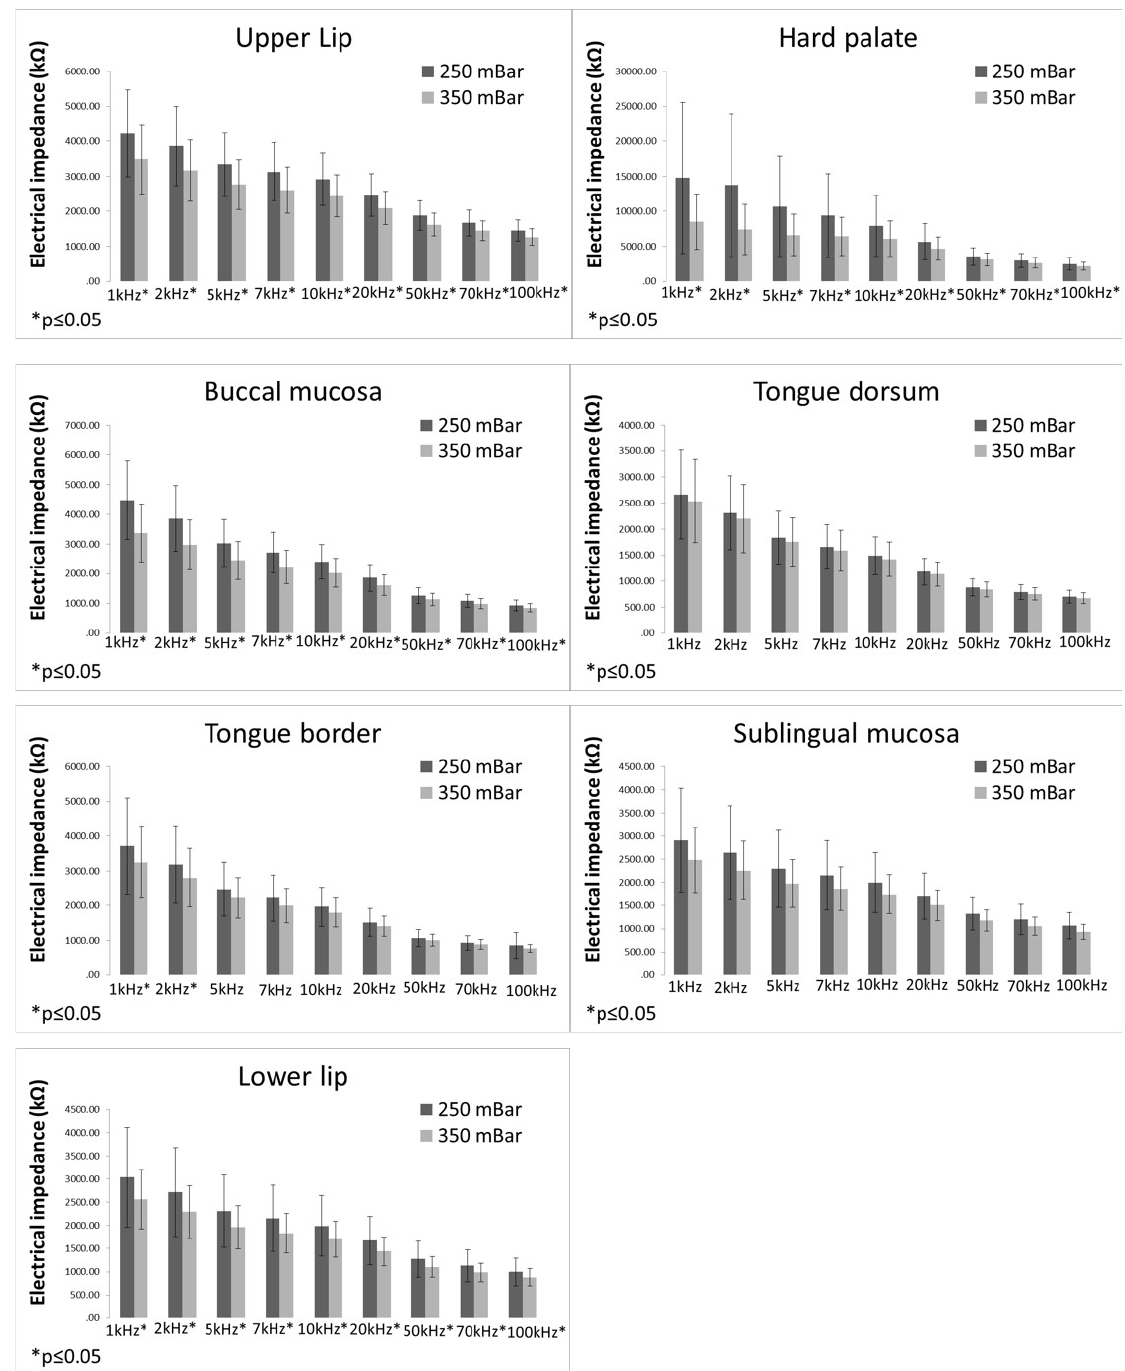
Figure 4. Electrical impedance measurements with different sub-pressures (bars representing mean ± standard deviation).